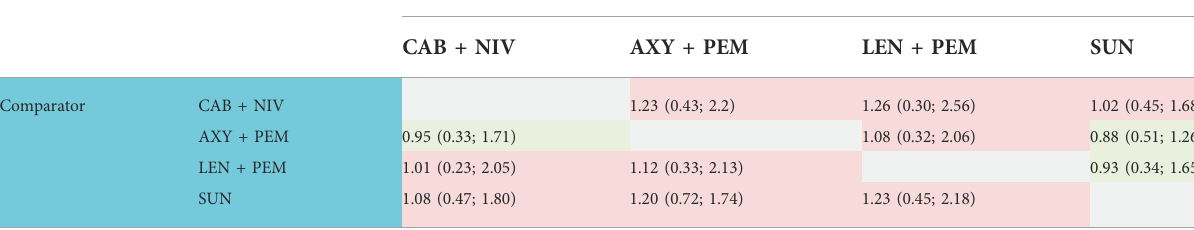
Thevaluesineachcellrepresenttherelativetreatmenteffectfortheinterventiononthetopwhencomparedtotheinterventionontheleft.Greensuggestsarelativetreatmentbene fi t(light greenanonsigni fi cantbene fi t,anddarkgreenasigni fi cantbene fi t).Redsuggestsarelativetreatmentharm(lightredanonsigni fi cantharm,anddarkredasigni fi cantharm).AXY,axitinib; CAB, cabozantinib; IPI, ipilimumab; LEN, lenvatinib; NIV, nivolumab; PEM, pembrolizumab; SUN,